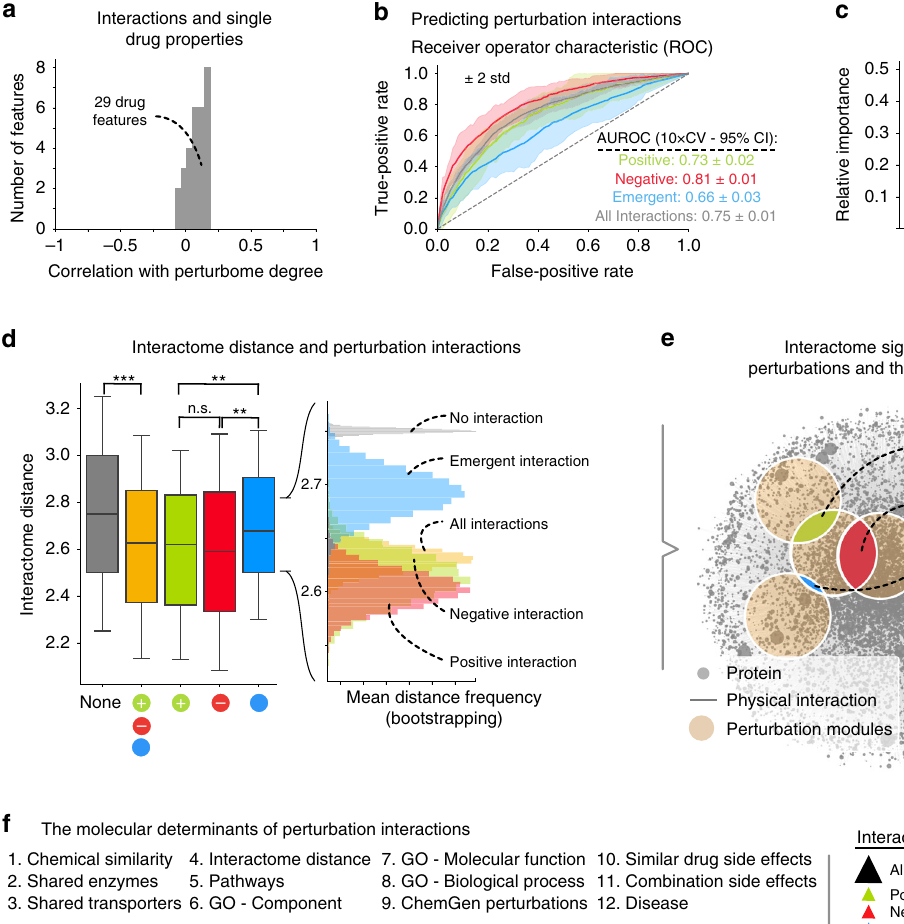
are strongly associated with an overlap of their respective perturbation modules. Figure 5g condenses the commonalities and differences among the three interaction types in terms of molecular and pathophy- siological fi ngerprints. For example, positive interactions are more strongly associated with chemical similarity than the other NATURE COMMUNICATIONS| (2019) 10:5140